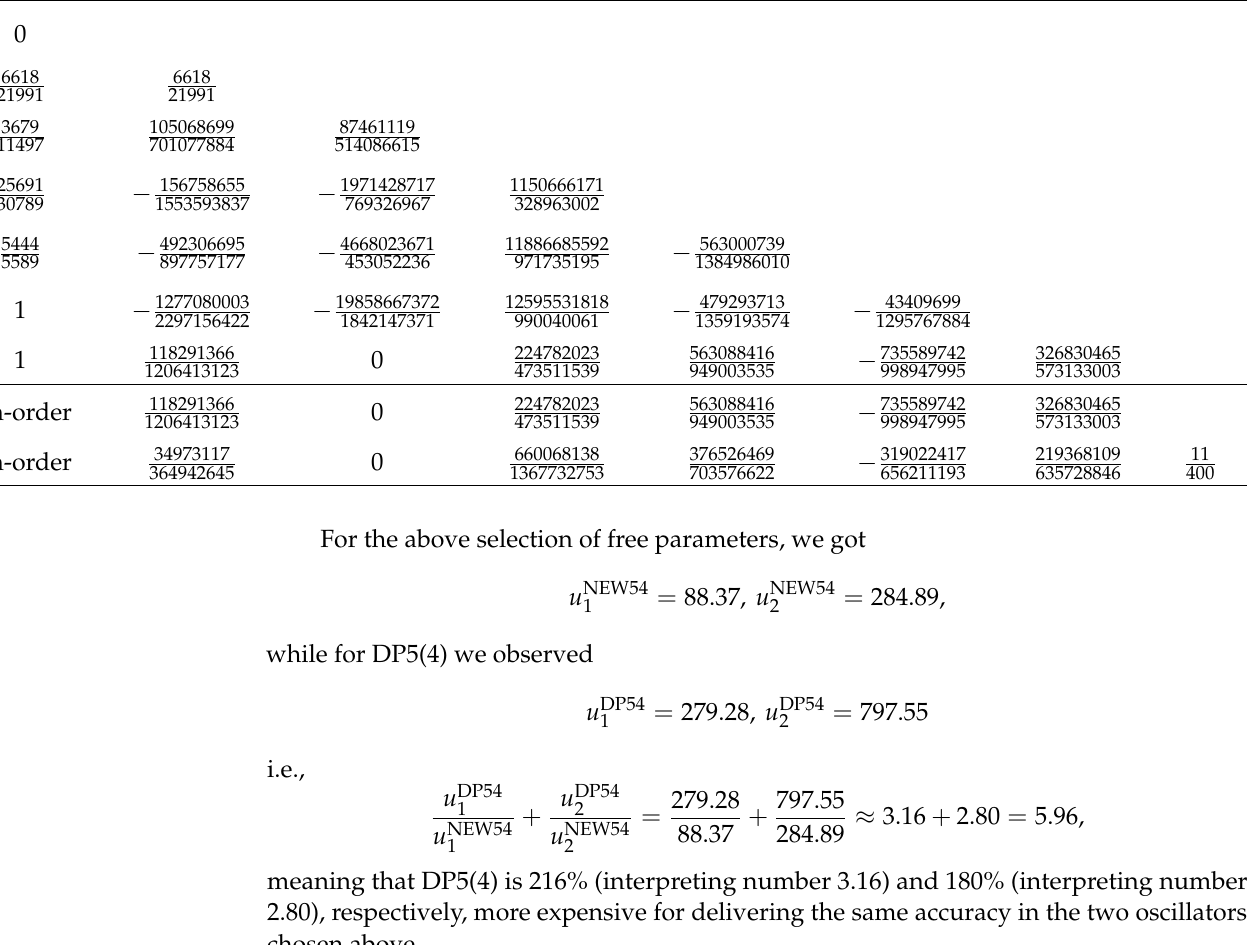
Table 1. Coefficients of NEW5(4) pair, accurate for double precision